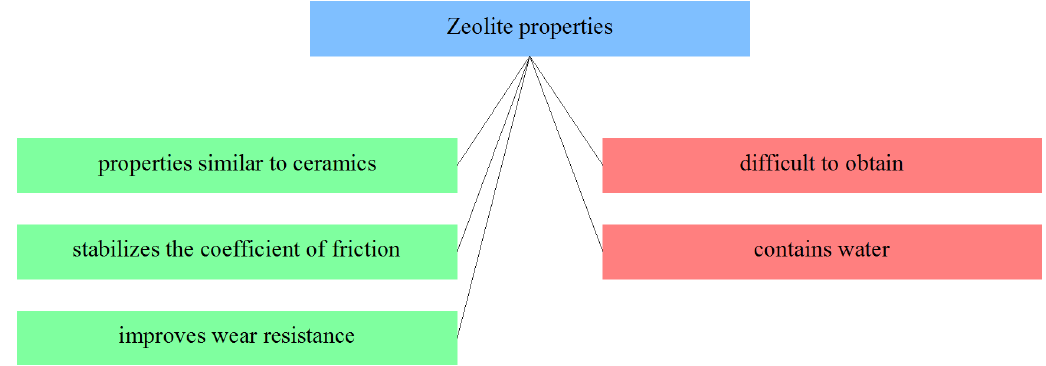
Figure 28: Selected zeolites composites properties from the point of view of applicability in friction materials